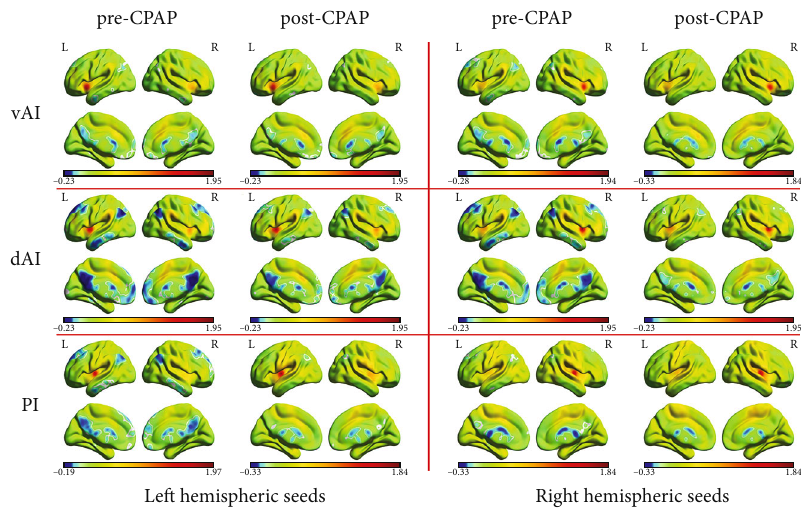
Figure 2: The distribution patterns of resting-state functional connectivity in di ff erent insular subregions are highly similar in pre-CPAP OSA and post-CPAP